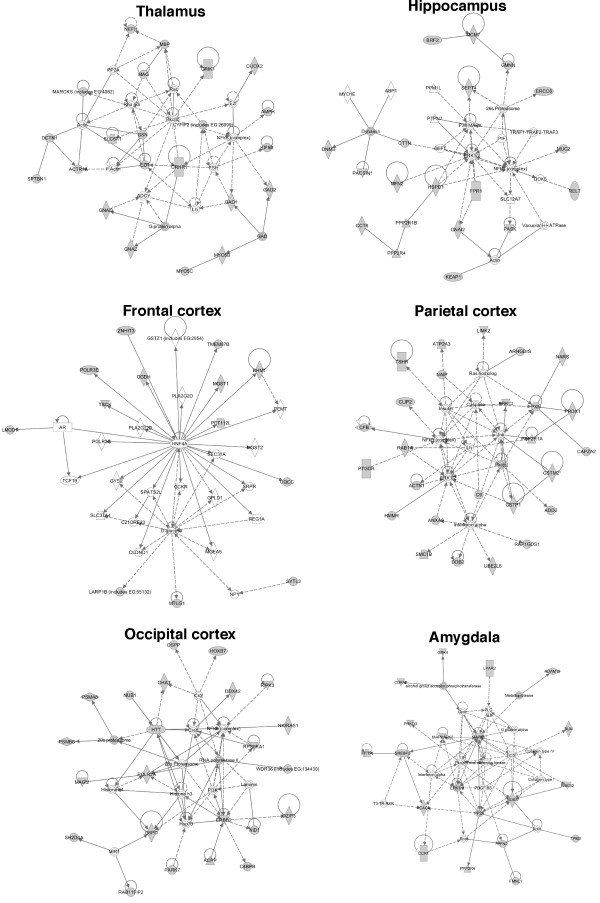
Network analysis of proteins identified in each region of rat brain by Ingenuity pathway analysis. The networks were analyzed based on the data of proteins identified in the indicated regions of rat brain. The networks were revealed as circles (genes) and lines (biological relationship). Solid lines mean direct interaction, and dotted lines show indirect interactions between the genes.